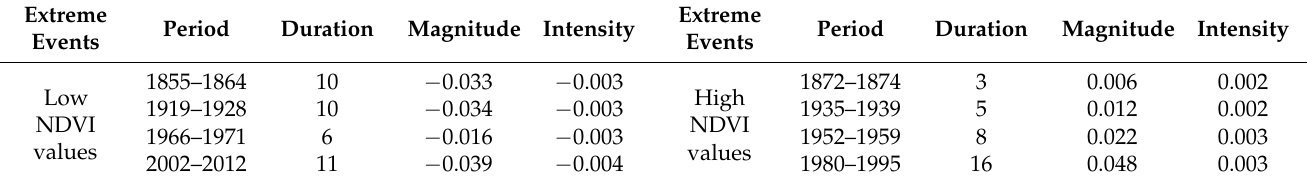
Table 4. Reconstruction of low vegetation greenness and high vegetation greenness periods, and their scale and intensity in the western Greater Khingan